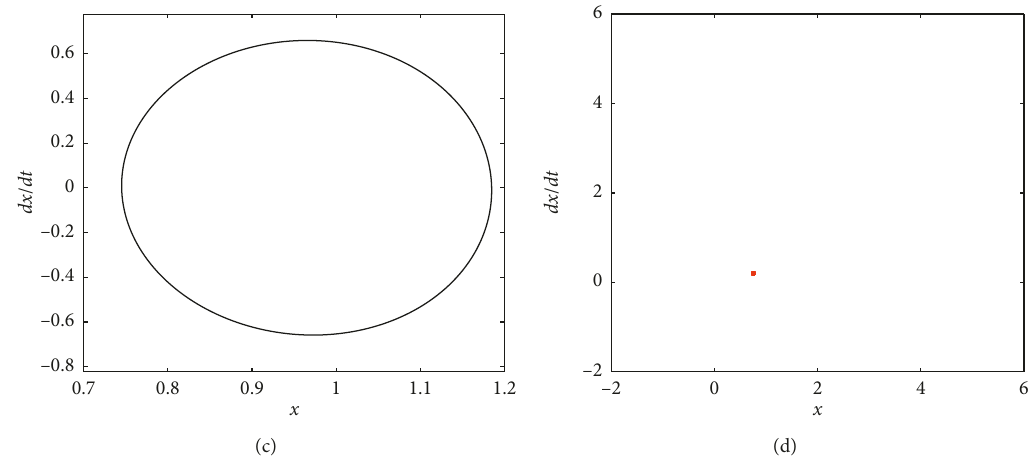
Figure 9: System response at ω � 3 rad/s and F � 1.5N: (a) time history; (b) frequency spectrogram; (c) phase portrait; (d) Poincare maps.